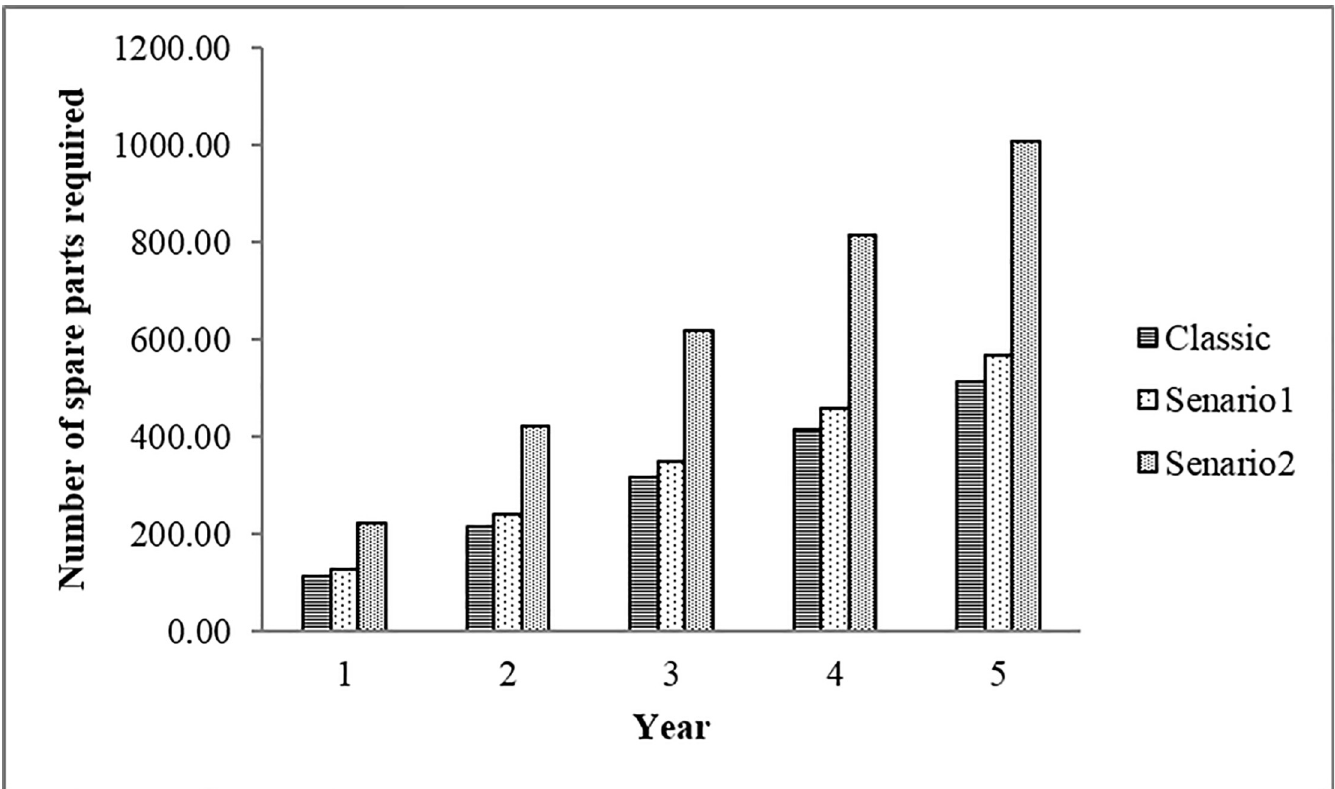
Fig 4. The number of EBN.